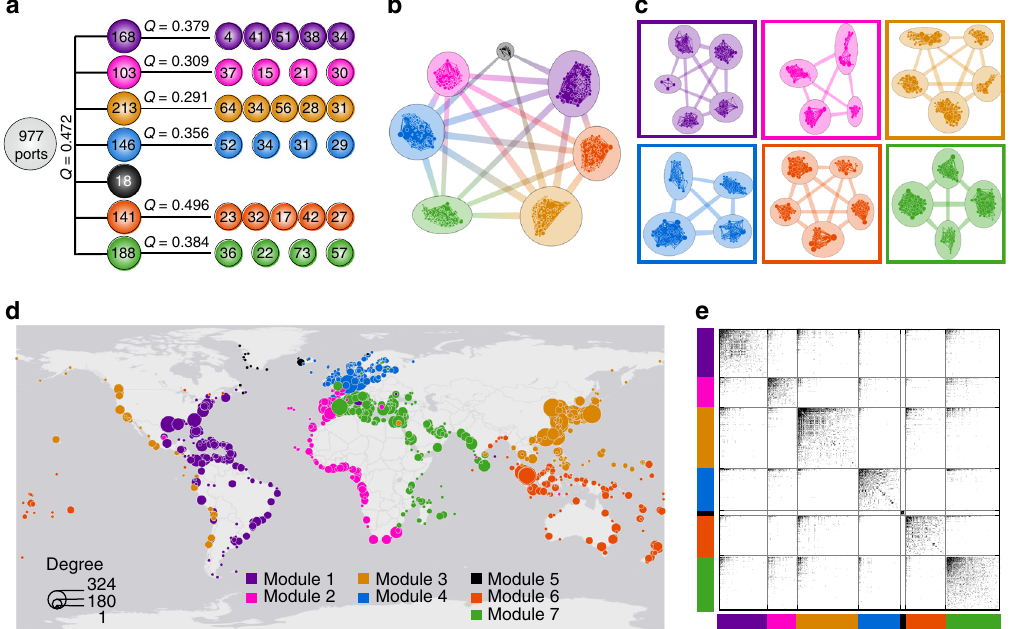
Fig. 3 Multiscale modular communities in the GLSN. In ( a – c ), we give results for the division of both modular and submodular port communities. a Values of the modularity index ( Q ), together with the size of each module (i.e., number of ports); see “ Methods ” for a formal de fi nition of Q . The network plots show the extracted modules ( b ) and the submodules ( c ); larger separation between models (submodules) is adopted to visualize the weaker connections between them, and inter-module (inter-submodule) connections are simpli fi ed. In ( d and e ), we show the results for the division of modular port communities. d A geographical plot presenting the seven modular communities by color. e A matrix plot presenting intra-module and inter-module links, with color black indicating a pair of ports are linked and color white unlinked; in each module ports are sorted in a descending order of